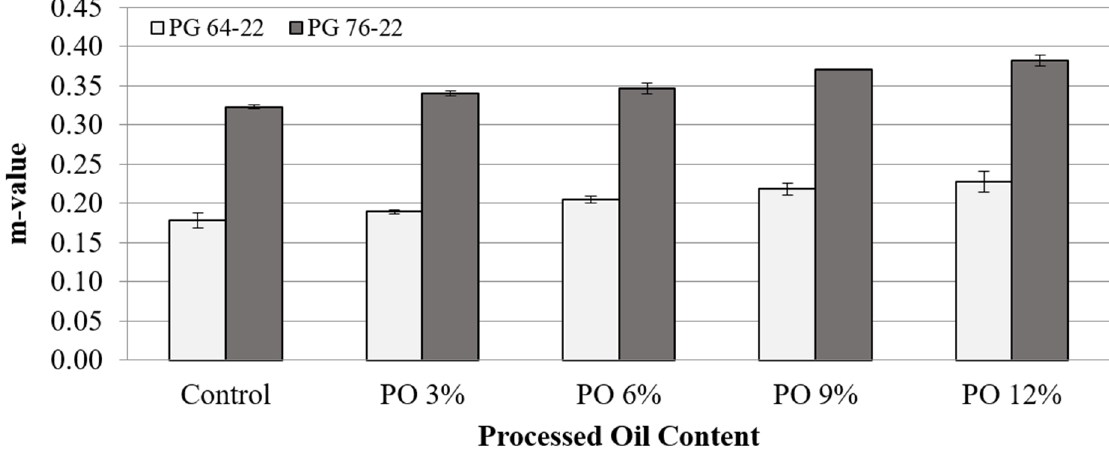
Figure 11. m ‐ value of asphalt binder with processed oil at − 24 °C. Figure 11. m-value of asphalt binder with processed oil at − 24 ◦ C. The statistical analysis of changes in stiffness as a function of processed oil content at temperatures of − 12 °C and − 24 °C is shown in Tables 8 and 9, respectively. In general, asphalt modification resulted in a significant difference at a temperature of − 12 °C. How ‐